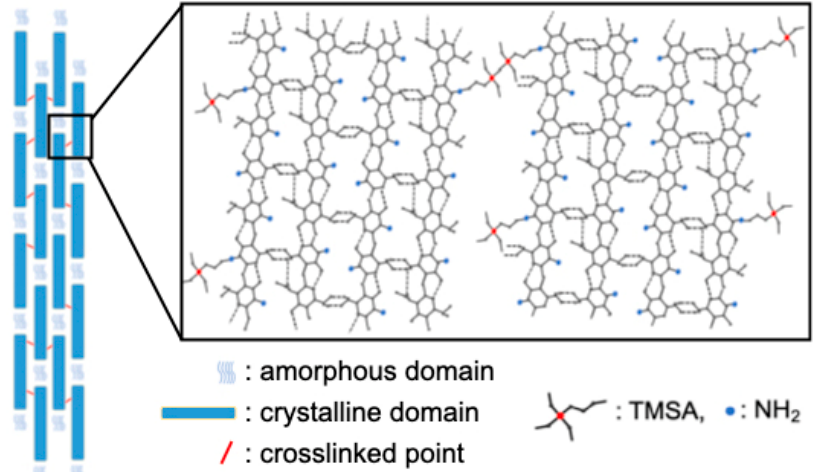
Figure 10. Structural model of the chitosan − TMSA (ChTMSA001) fiber.